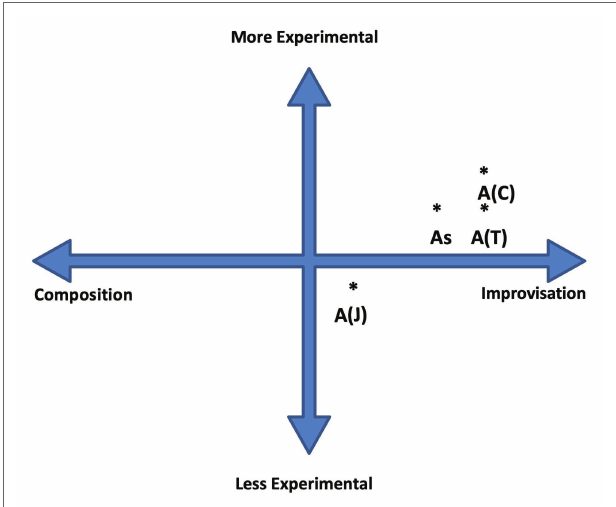
FIGURE 6 | 4 ′ 33 ″ : ECIC diagram showing performer and audience relationships. The asterisk indicates the performer’s position on the ECIC at points (sections) A, B, C, and D, as referred to in the